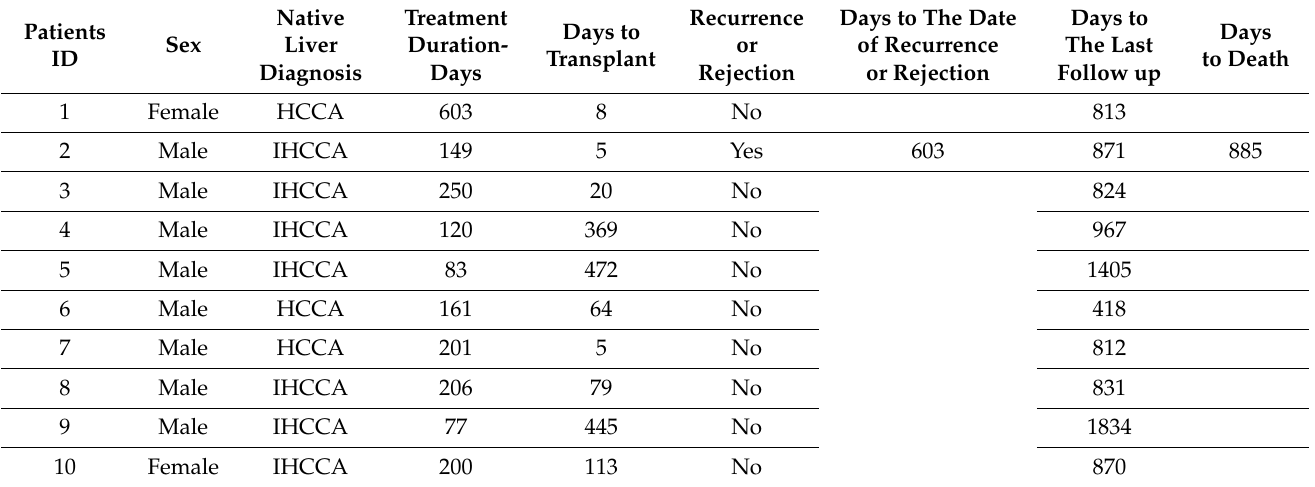
Table 1. Patients’ details who received gemcitabine plus cisplatin as a neo-adjuvant treatment for cholangiocarcinoma prior to liver transplantation with their related outcomes.